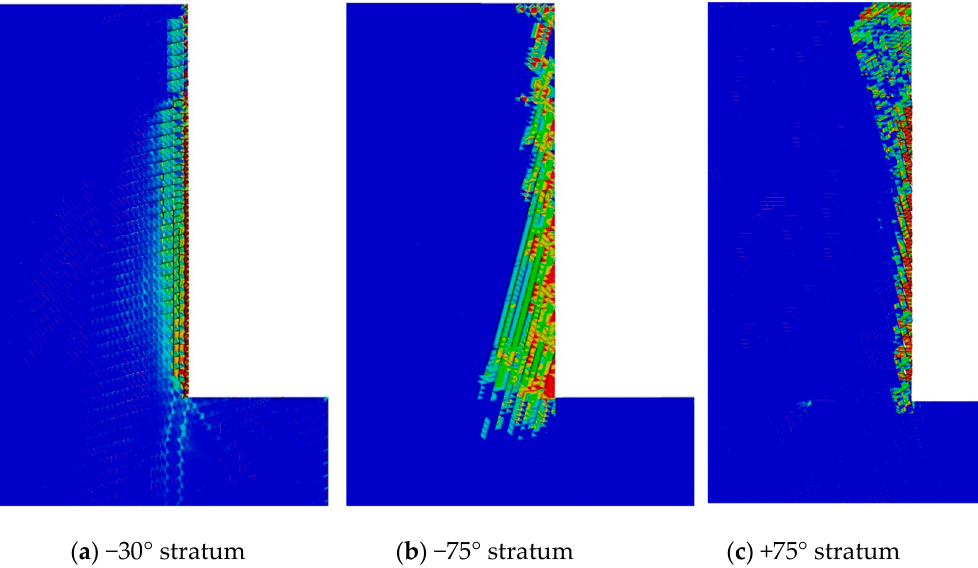
Figure 10. Fracture range and fracture development of the rock mass behind the borehole under different rock dip conditions.